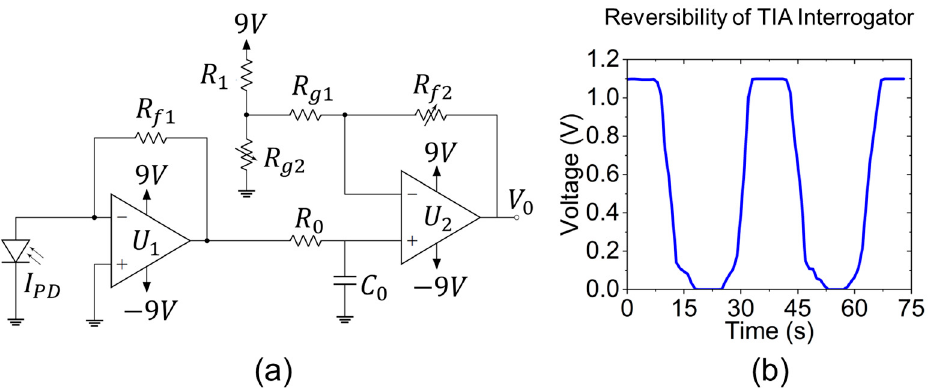
Figure 6. ( a ) Circuit diagram of the dual-stage transimpedance amplifier. ( b ) Reversibility of low-cost interrogator voltage signal tailored to the baseline reflectance of the reflective fiber sensor.